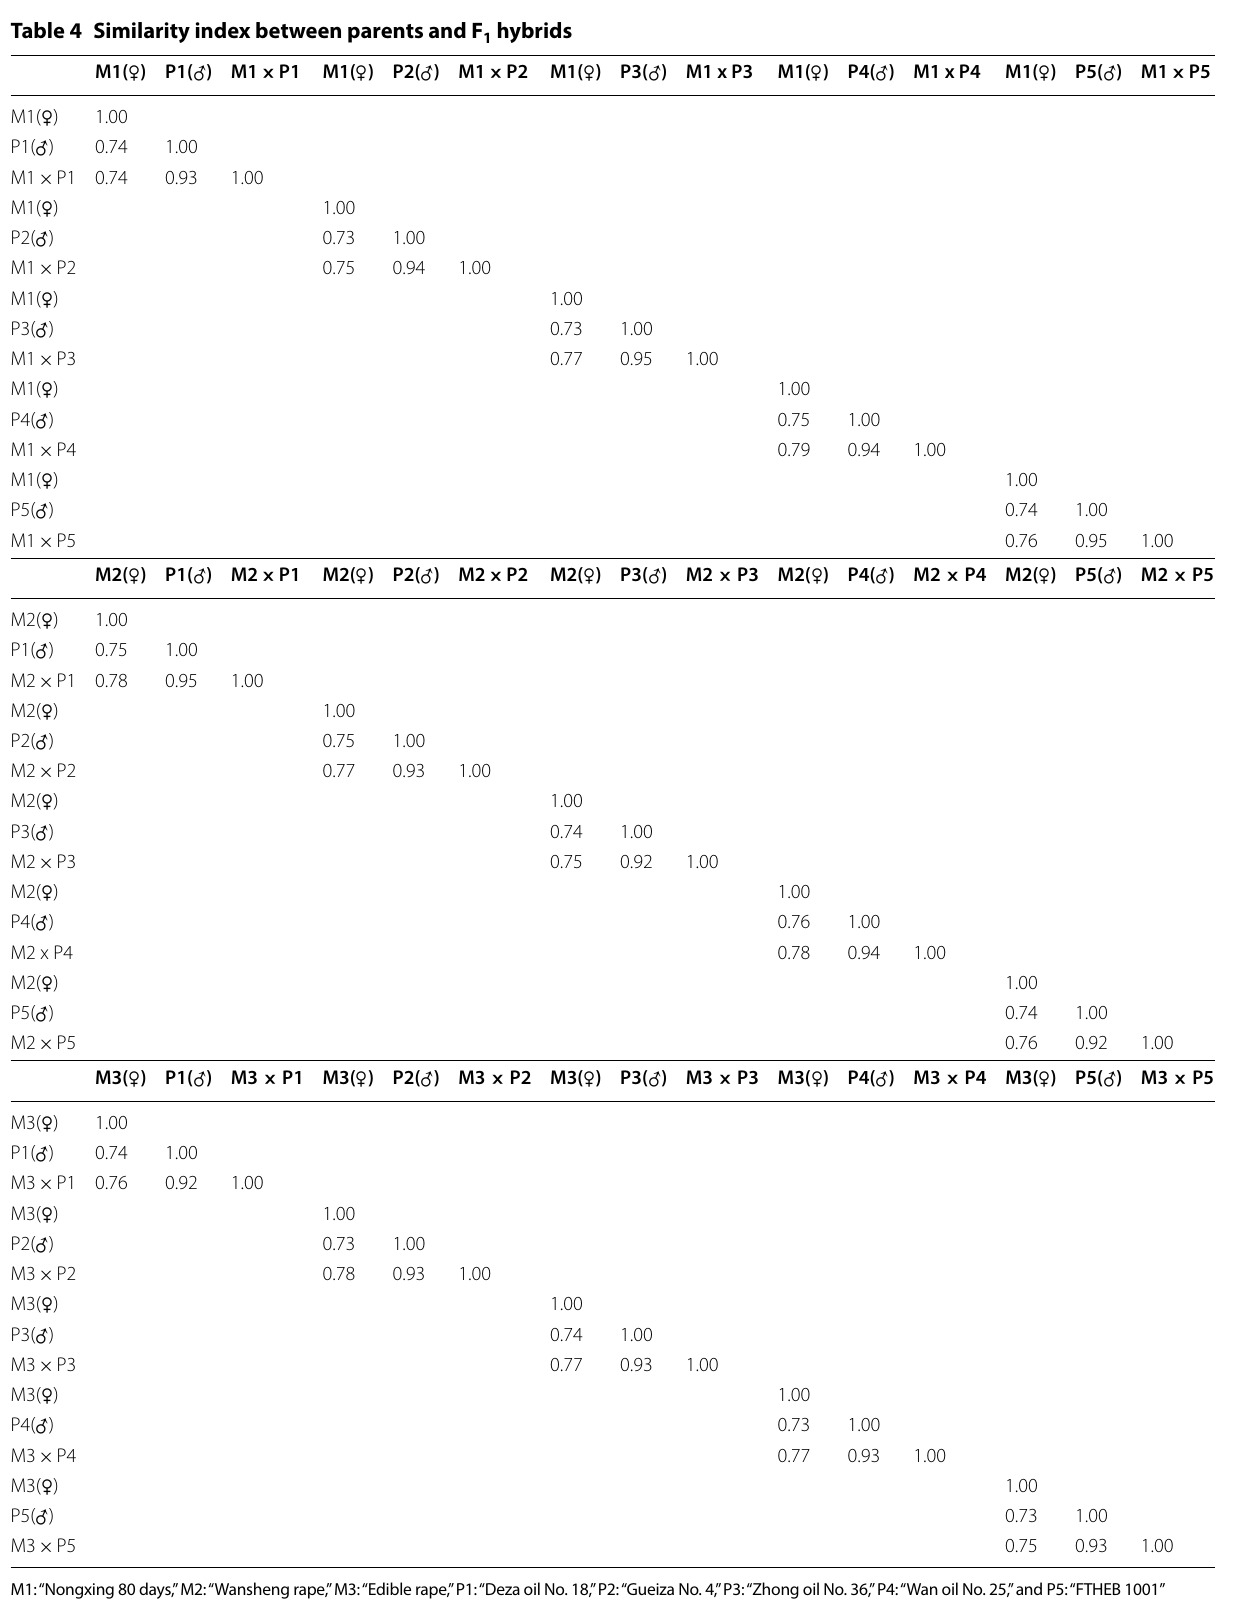
Table 4 Similarity index between parents and F